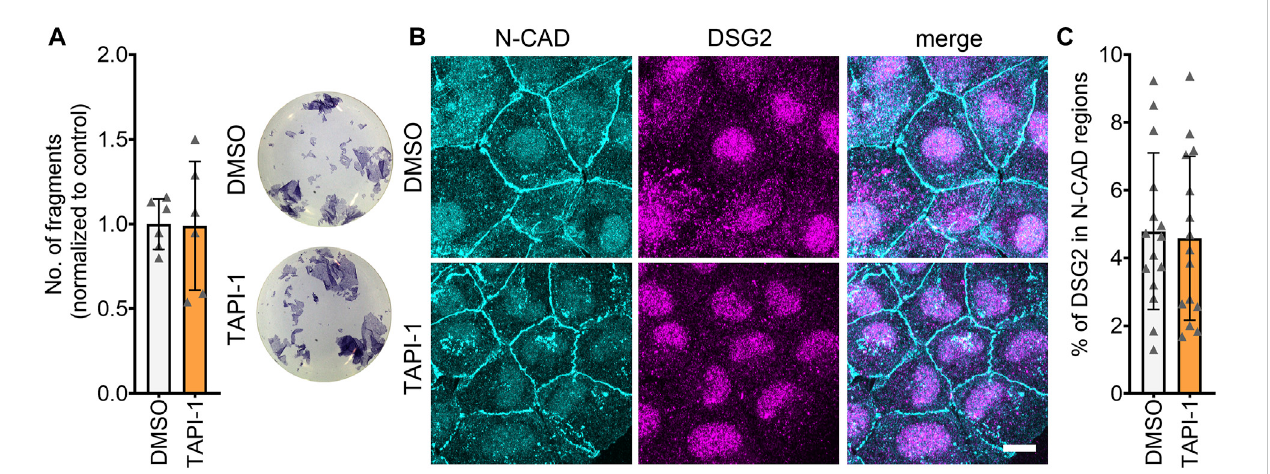
FIGURE 5 Desmosomal assembly is not enhanced upon inhibition of ADAM17. (A) Dispase-based dissociation assays in HL-1 cardiomyocytes after a Ca 2+ -switch followed bytreatment withTAPI-1for90 minwithrepresentativepictures ofthewells. N =8,unpairedStudent ’ s t -test,* p ≤ 0.05. (B) Maximum projectionsof immunostainingsin HL-1 cardiomyocytes for N-CAD and DSG2showing nochangesinN-CAD andDSG2localizationafter aCa 2+ -switch followed byTAPI-1 treatment.Z-scansspanningthewholecellvolume,z-steps=0.25 µm.Scalebar:10 µm. (C) Quanti fi